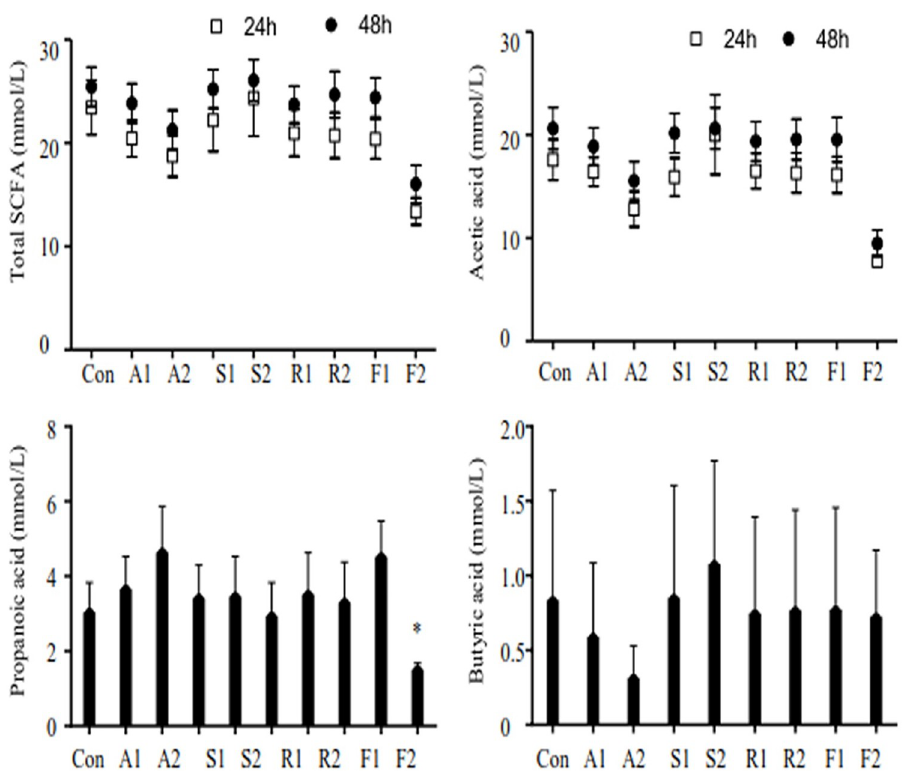
Fig 6. Effect of statins on SCFA production after fermentation. Acetic, propionic, isobutyric, butyric, isovaleric, and valeric acid were detected using GC in this paper. Each sample was measured in triplicate. Figures were generated using GraphPad Prism version 5.01. The figure shows total SCFA, acetic, propionic, and butyric acid concentration of the following samples: (1: 20 μ M; 2: colon concentration; A: ATO; S: SIM; R: ROS; F: FLU).